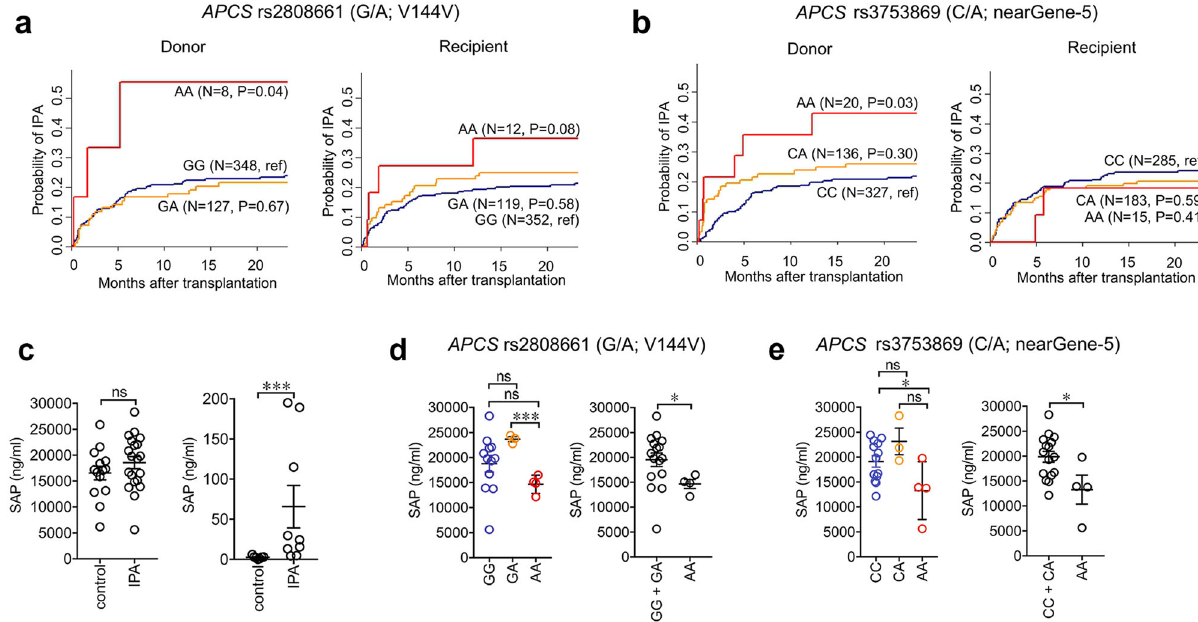
Fig. 7 SNPs in APCS predispose stem-cell transplant recipients to IPA. a , b Cumulative incidences of IPA according to APCS genotypes (IFIGEN cohort) are shown. a Cumulative incidence according to donor or recipient rs2808661 genotypes: donor GG (22.8%, n = 348, reference), GA (21.4%, n = 127; P = 0.67) and AA (55.6%, n = 8; P = 0.04), and recipient GG (20.3%, n = 352, reference), GA (25.0%, n = 119; P = 0.58) and AA (36.4%, n = 12; P = 0.08). b Cumulative incidence according to donor or recipient rs3753869 genotypes: donor CC (20.6%, n = 327, reference), CA (25.9%, n = 136; P = 0.30) and AA (42.9%, n = 20; P = 0.03), and recipient CC (23.4%, n = 285, reference), CA (20.4%, n = 183; P = 0.59) and AA (18.2%, n = 15; P = 0.41). Data were censored at 24 months, and relapse and death were competing events. a , b P -values are for Gray ’ s test (two-sided). c Levels of SAP in sera (left) and BALFs (right) of hematological patients from the FUNBIOMICS cohort. Sera, controls, n = 14; IPA, n = 20. BALFs, n = 7; IPA, n = 9. Mean ±SEM. *** P = 0.0007 (two-sided, Mann – Whitney U -test). d , e Levels of SAP in serum of IPA patients with donor rs2808661 ( d ) and donor rs3753869 ( e ). Donor rs2808661, GG ( n = 12), GA (n = 3), AA ( n = 4) ( d ) and Donor rs3753869, CC ( n = 13), CA ( n = 3), AA ( n = 4) ( e ) analyzed separately for the different genotype ( d , e , left) or AA vs. GG + GA ( d , right) and AA vs. CC + CA ( e , right). AA vs. GA, *** P = 0.0006 (two-sided, unpaired t -test); AA vs. GG + GA, * P = 0.05 (two-sided, Mann – Whitney U -test); AA vs. CC, * P = 0.03 (two-sided, unpaired t -test); AA vs. CC + CA, * P = 0.02 (two-sided, unpaired t -test). c – e , Mean ±SEM.